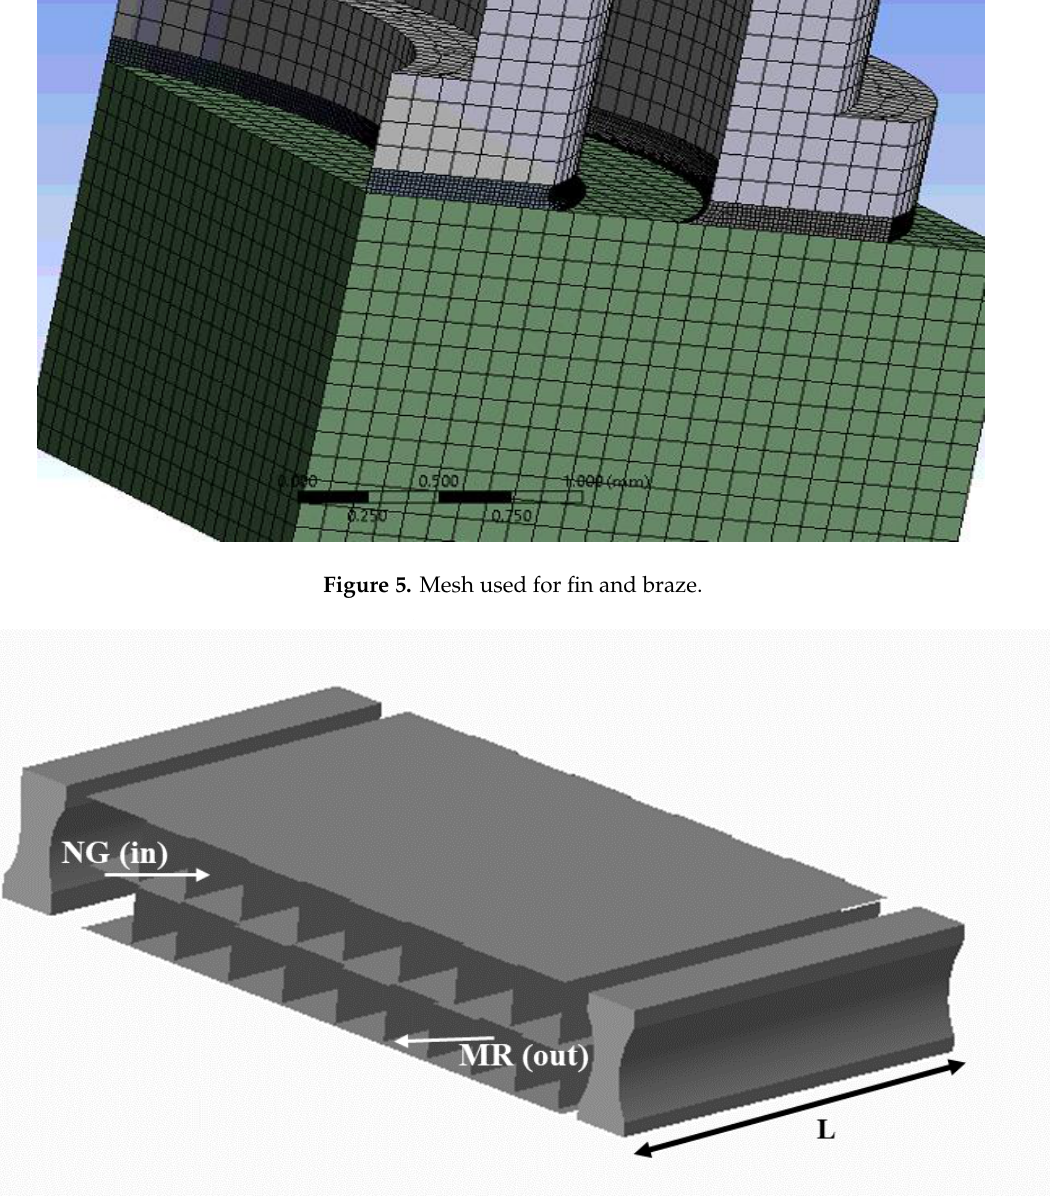
Figure 5. Mesh used for fin and